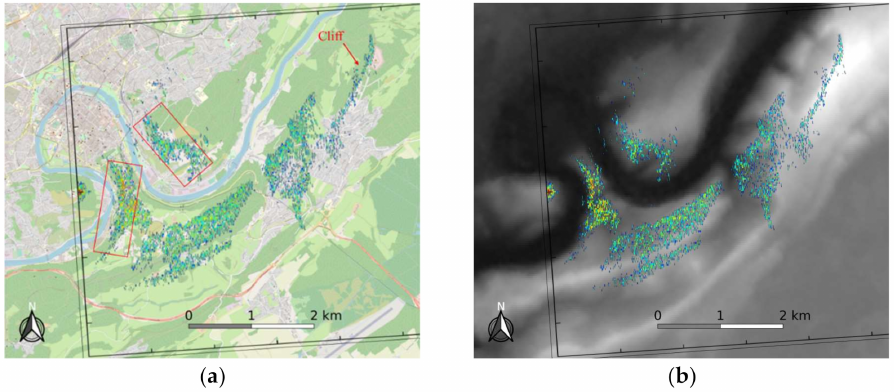
Figure 13. MF-PB-SAR image of the mountainous area in Besançon during an ascending pass with the satellite beam facing east, overlaid with ( a ) the aerial picture provided by OpenStreetMap and ( b ) the digital elevation model (DEM).